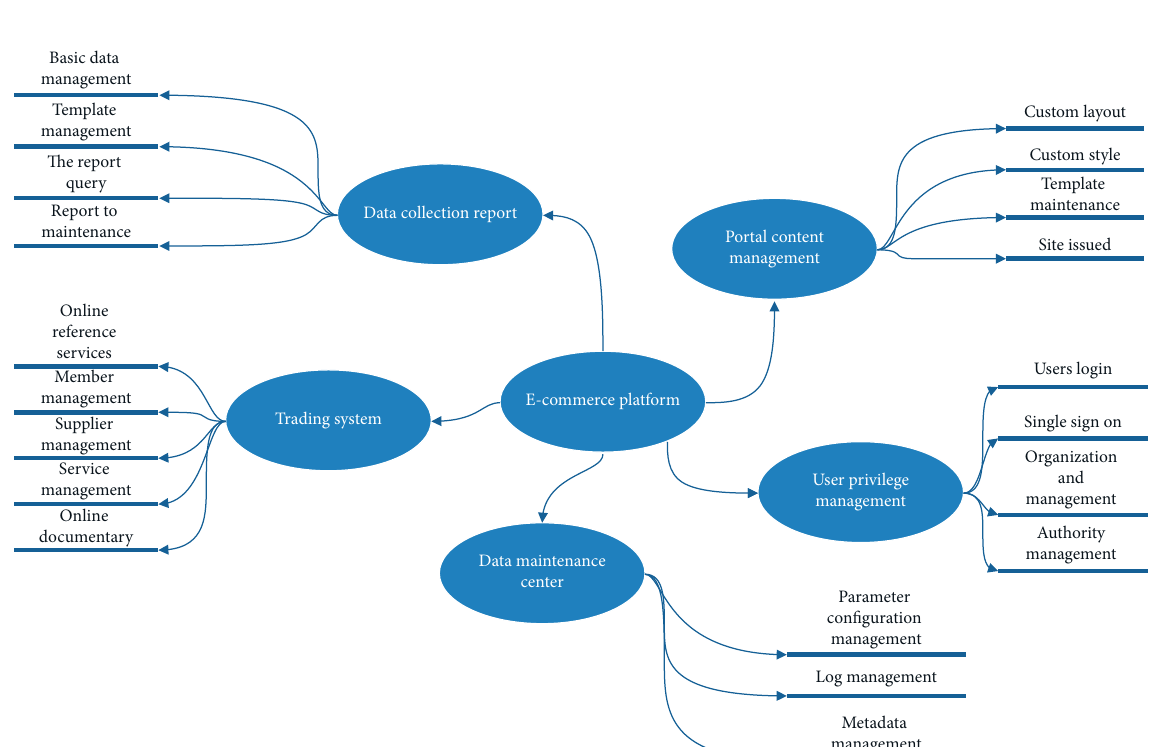
Figure 2: Function overall